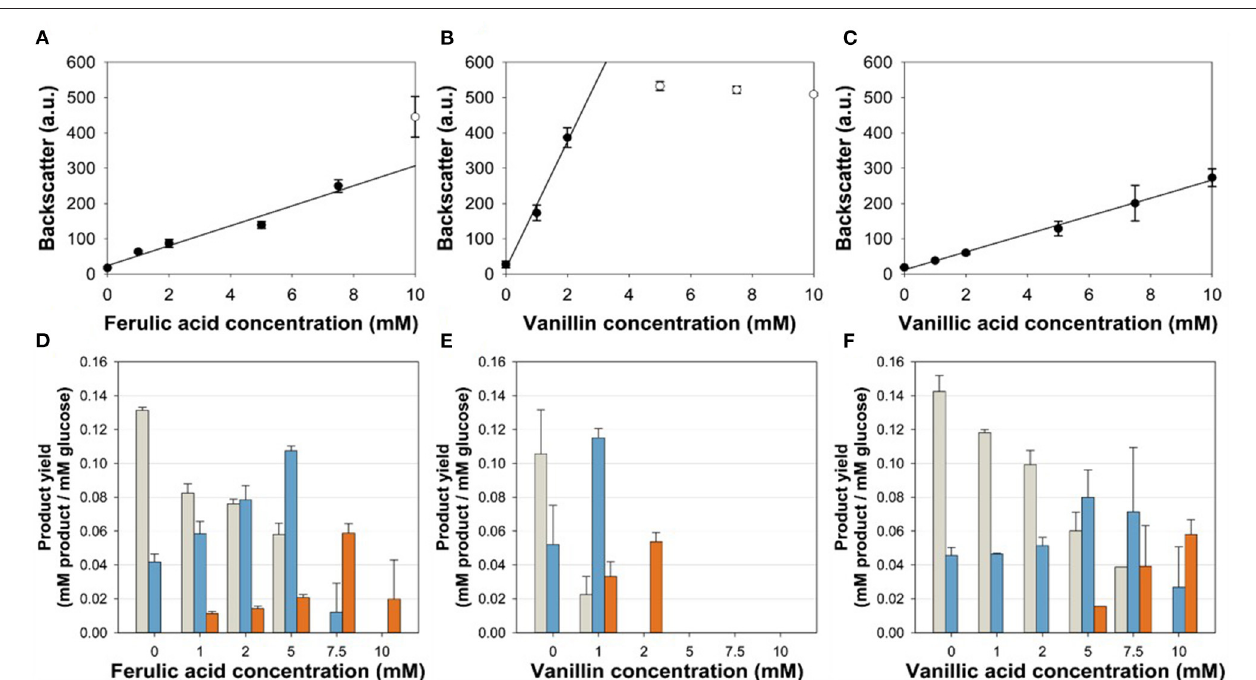
FIGURE 3 | (A,C) Correlation of the final backscatter against the effector molecule concentration of C. glutamicum 1 P aceE :: vanR -P vanABK * in microliter scale cultivations with CGXII minimal medium and 20g glucose L − 1 with different concentrations of (A) ferulic acid ( m = 28 backscatter units/mM; R 2 = 0.966), (B) vanillin ( m = 180 backscatter units/mM; R 2 = 0.989), and (C) vanillic acid ( m = 25 backscatter units/mM; R 2 = 0.996). Black line represents linear regression of black dots, while empty dots are excluded from this regression. (D–F) Product yields of the aforementioned cultivations for pyruvate (gray), alanine (blue), and valine (orange). Error bars represent standard deviation of at least three